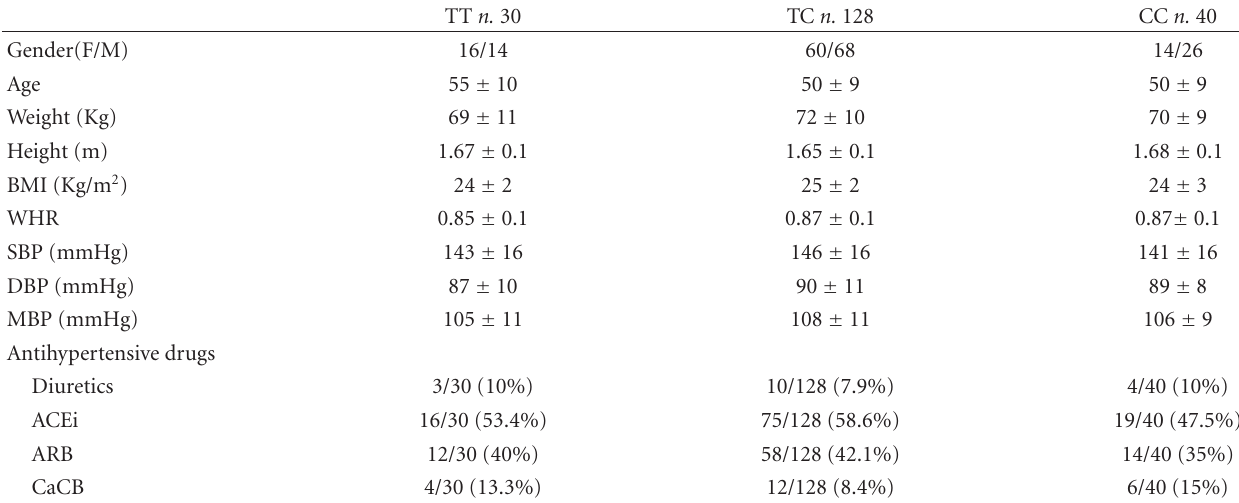
Table 2: Distribution of clinical measurements in the hypertensives with left ventricular hypertrophy subgrouped according to Leu 10 → Pro 10 TGF β 1 genotypes ∗ .